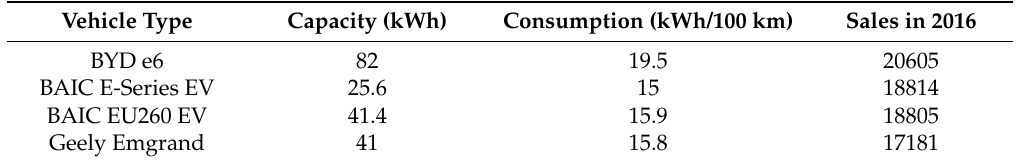
Table 1. Parameters and sales volume of top popular EVs in China.